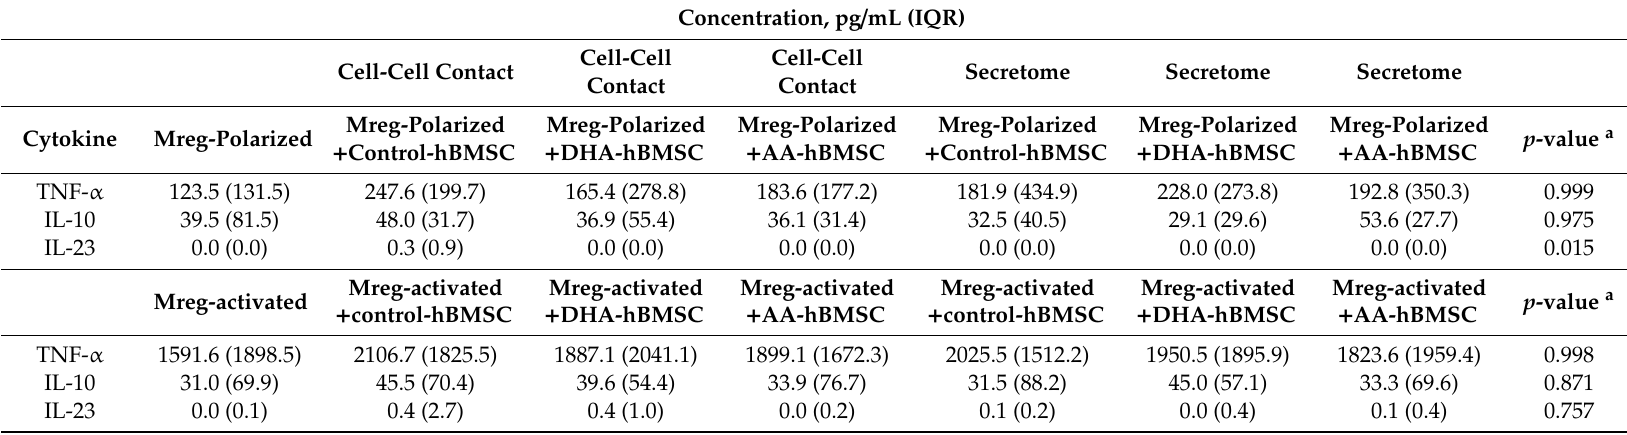
Table 1. E ff ect of hBMSC cell-cell contact and secretome with Mreg-polarized and Mreg-activated macrophages to cytokine